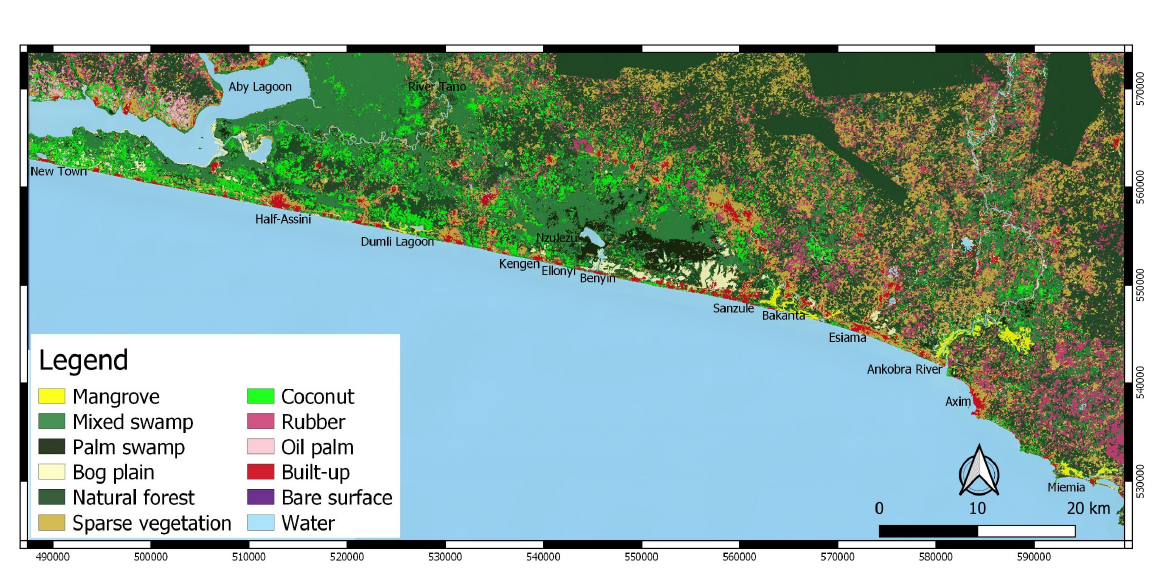
Figure 8. Land cover classification of the Greater Amanzule peatland based on the S2+S1+DEM dataset.